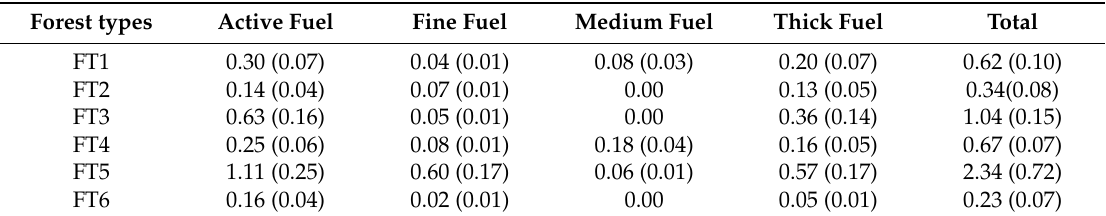
Table 2. Loadings of surface fuel classes (active fuel, fine fuel, medium fuel and thick fuel) by six forest types (unit: kg ¨ m ´ 2 ).